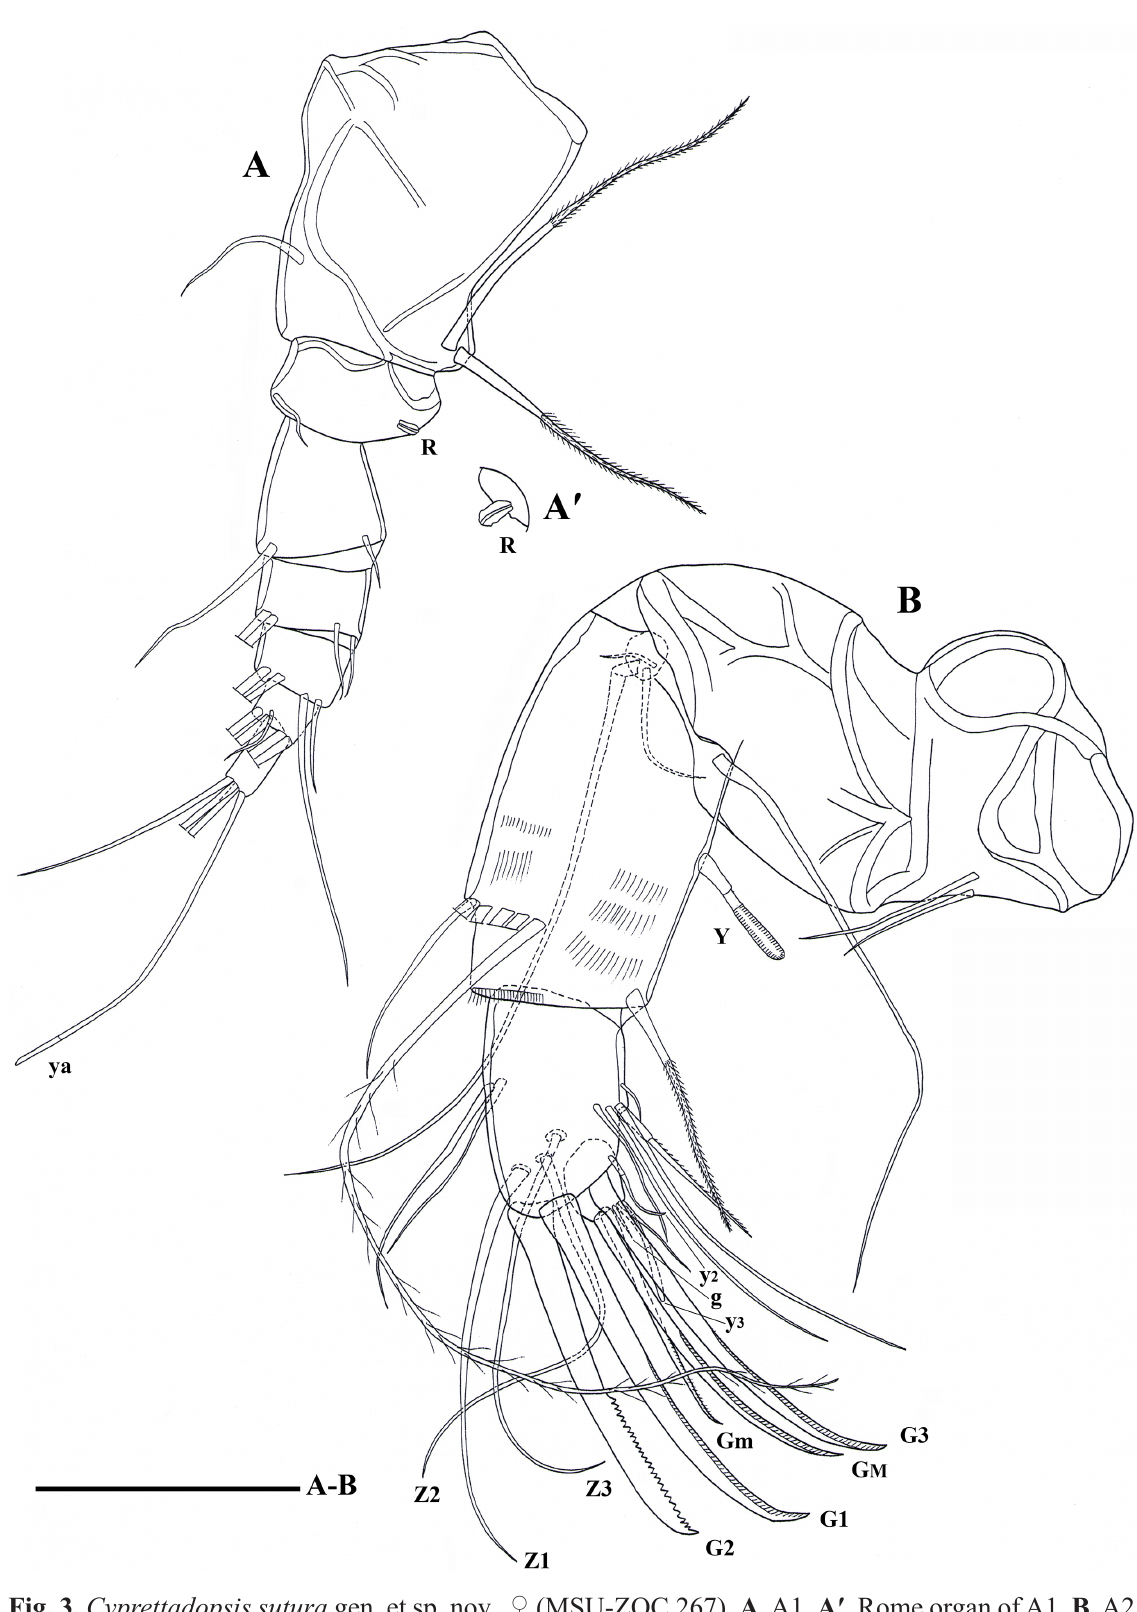
Fig. 3. Cyprettadopsis sutura gen. et sp. nov., ♀ (MSU-ZOC.267). A . A1. Aʹ . Rome organ of A1. B . A2. Scale bar: 50